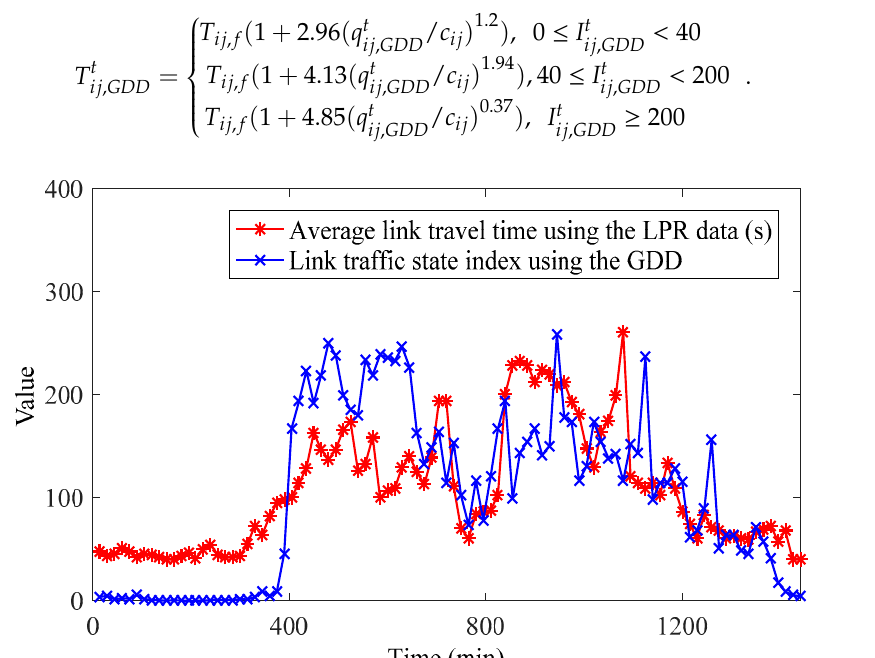
Figure 2. Relationship between average link travel time and traffic state index.